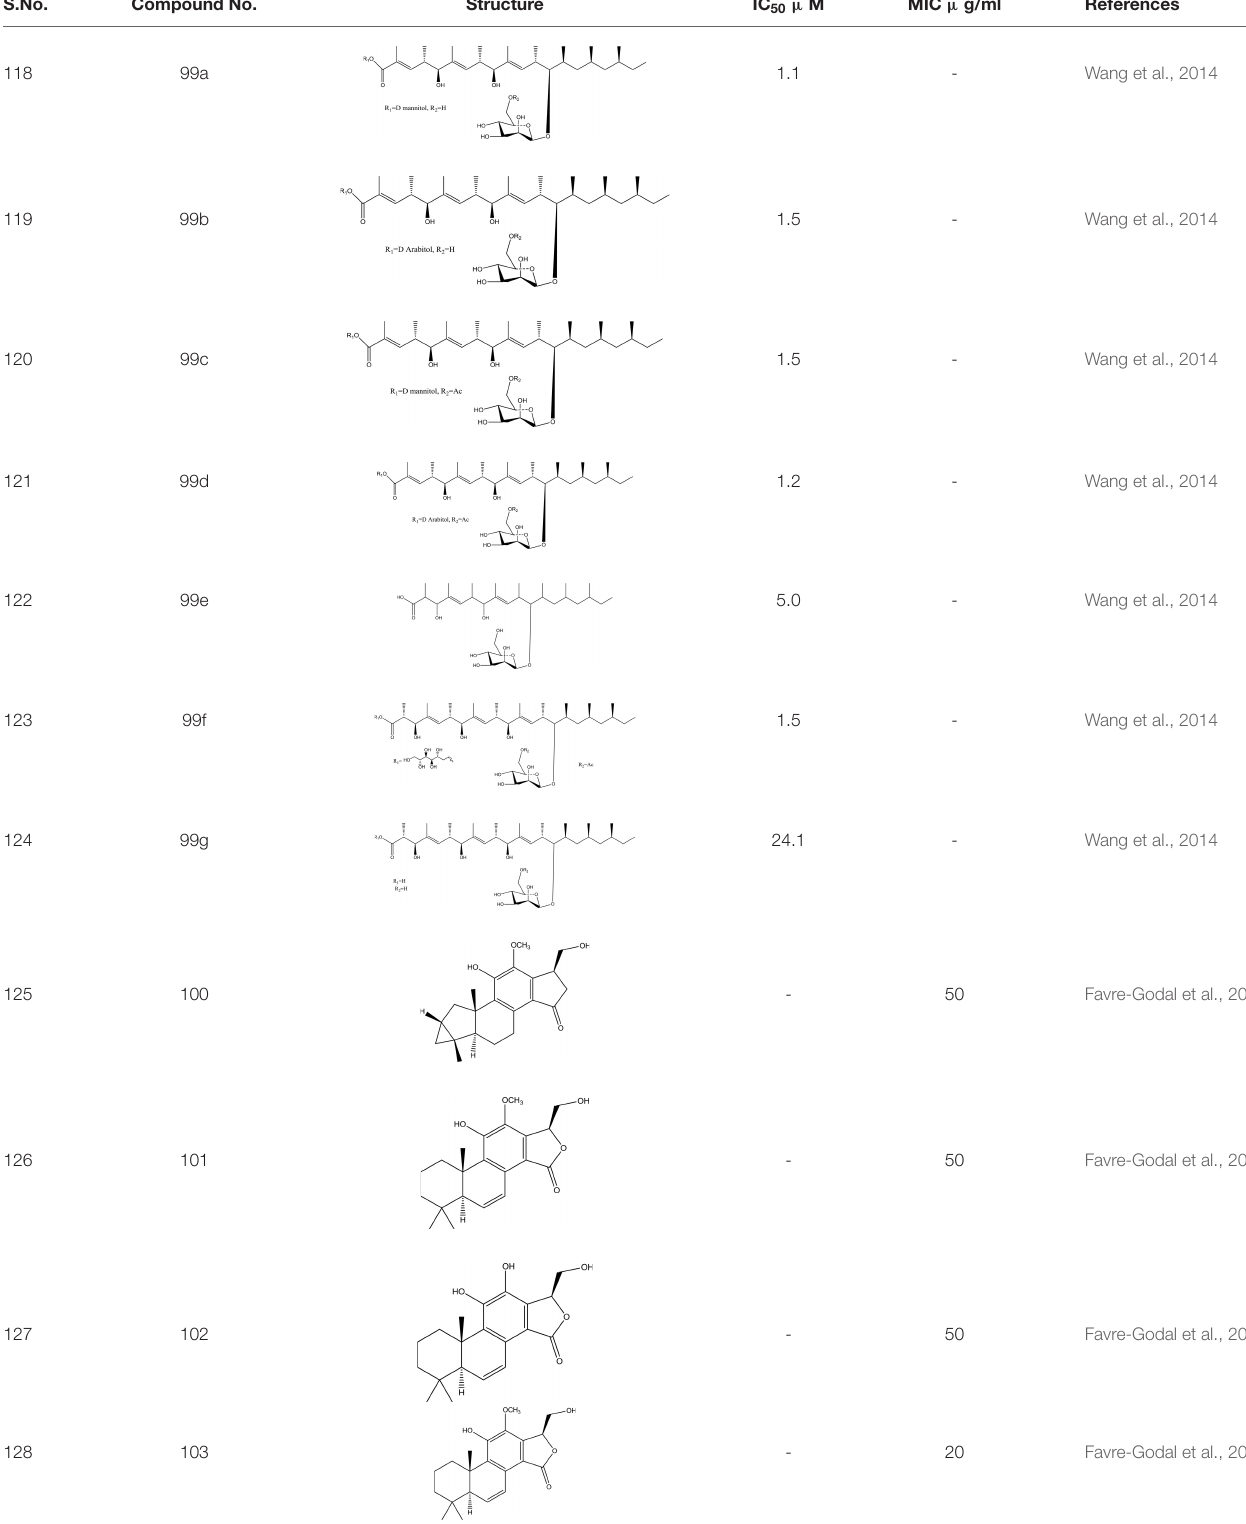
TABLE 7 | Chemical structures and MIC/IC 50 values of small molecule inhibitors (99–105). S.No. Compound